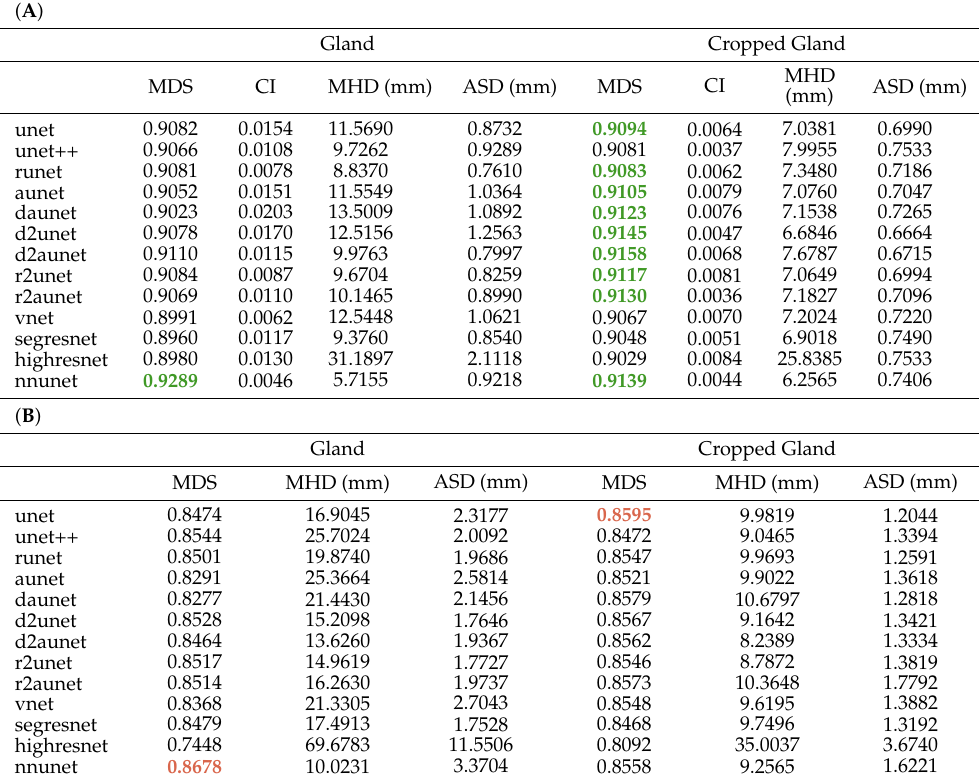
Figure 4. Boxplots showing the distribution of Dice, Hausdorff distance (HD) and Surface distance scores per model during cross-validation for the gland segmentation task. Each segment contains a pair of boxplots, where the left one corresponds to the results of the model on the full data, and the right one on the cropped data. Table 1. ( A ) Results obtained by the segmentation models on prostate gland segmentation task. The results presented are the mean scores from the validation data over the five-fold models.The best results (based on Table A1) for both the full and cropped volumes are presented in green. ( B ) Results obtained on the external test set by the segmentation models trained on the prostate gland segmentation task. The results presented are the mean scores of the 5-fold models over all the samples on the external test set. The best results for both the full and cropped volumes are presented in